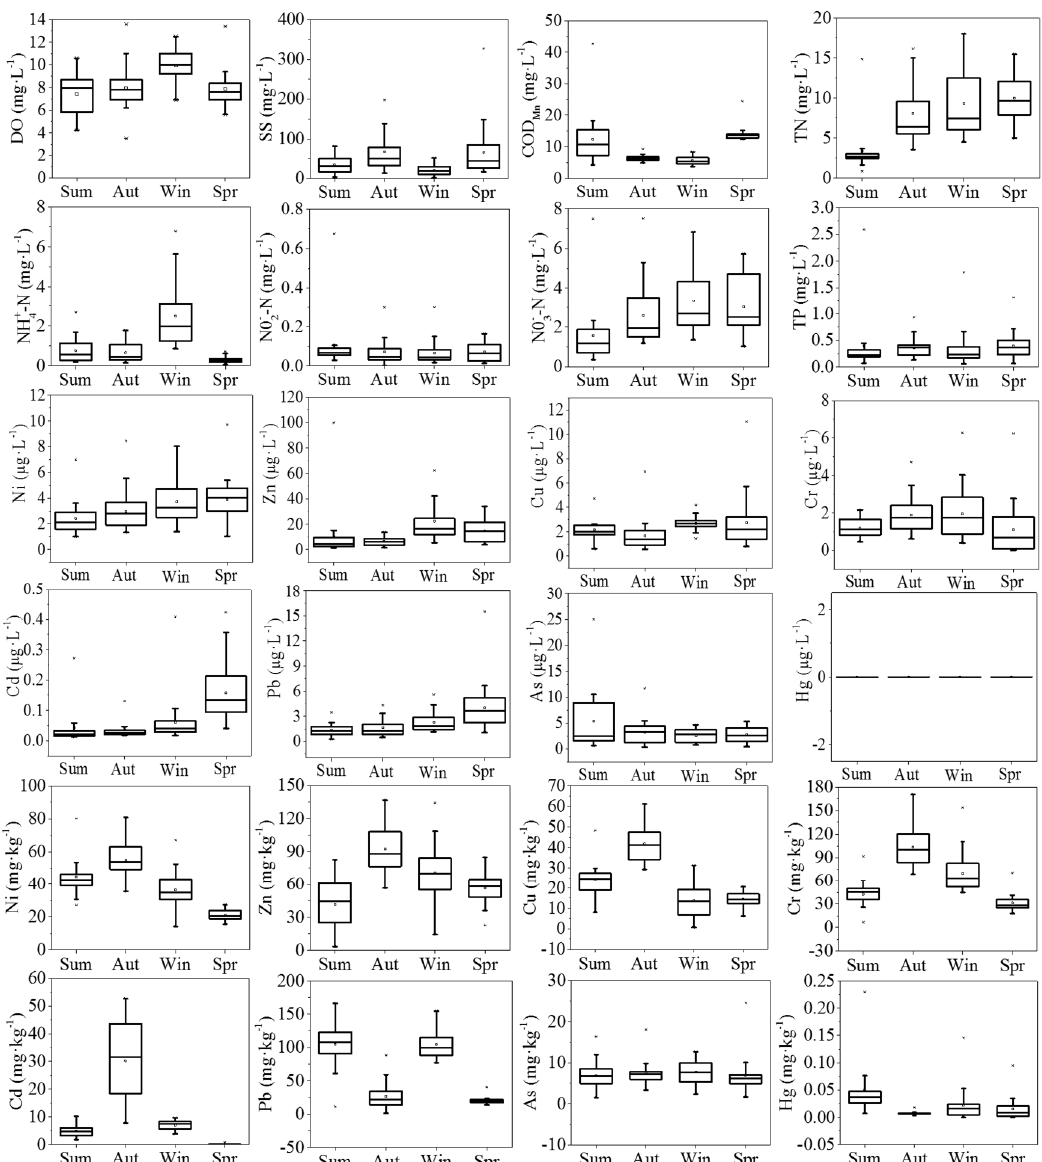
Figure 2. The temporal variations of environmental variables, including water quality and heavy metals pollution, in sediments at 27 monitoring stations of Huai River basin in the year